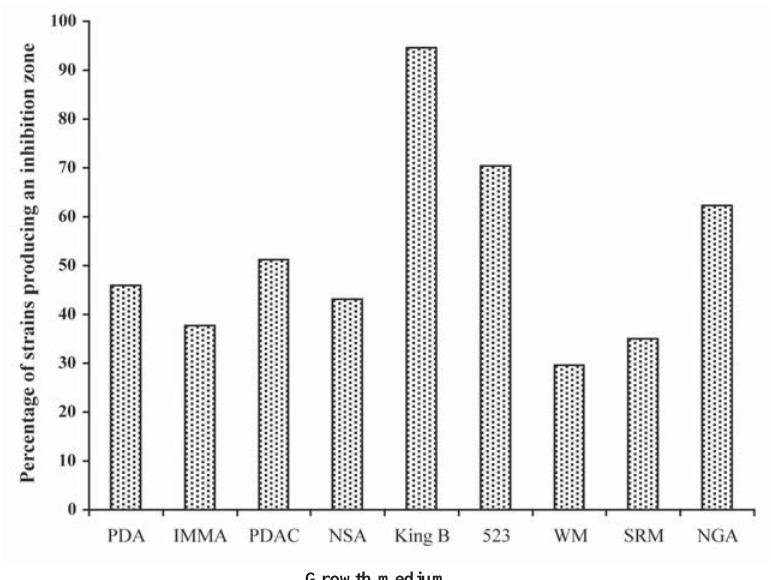
Fig. 2. Inhibition zone against Rhodotorula pilimanae produced by 33 pathovars of Pseudomonas syringae and 4 strains of P. avellanae on 9 different growth